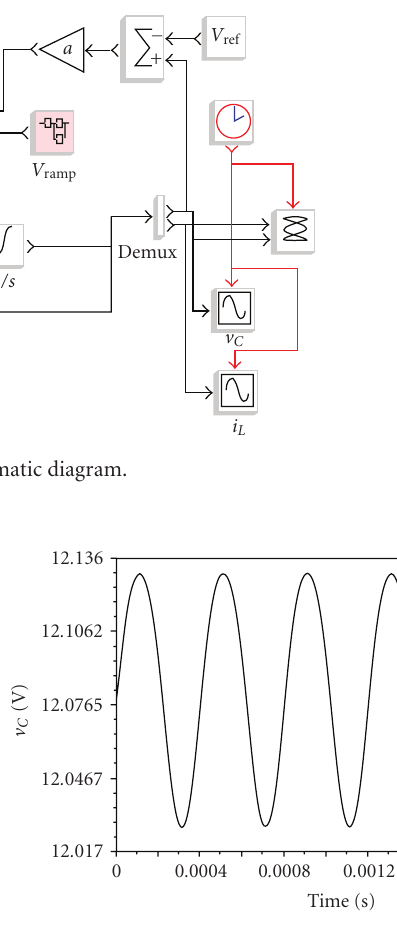
Figure 5: Fundamental periodic operation. ( E = 30V): time waveform of the capacitor voltage.